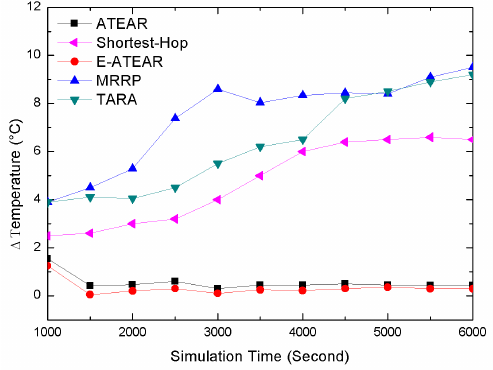
Figure 7. Temperature variation versus simulation time.